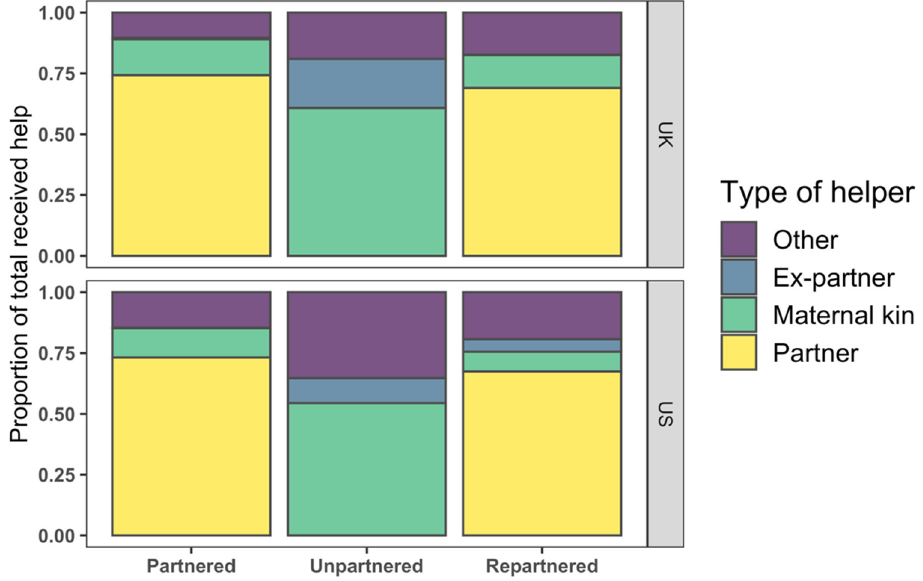
Figure 6. Proportion of total childcare help received (as a number of tasks performed over the course of a month) by type of allomother, according to partnership status of the mother, for each country separately.